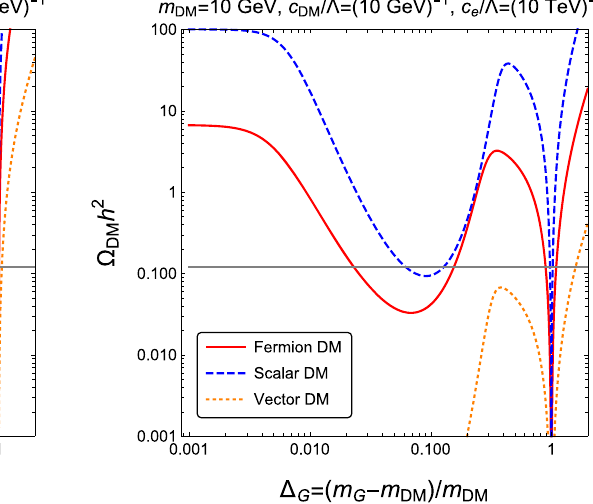
dark matter, respectively. We took m DM = 1 , 10GeV on left and right plots, respectively, and c DM = ( 10GeV ) − 1 and c e /(cid:3) = ( 10TeV ) − 1 for both plots